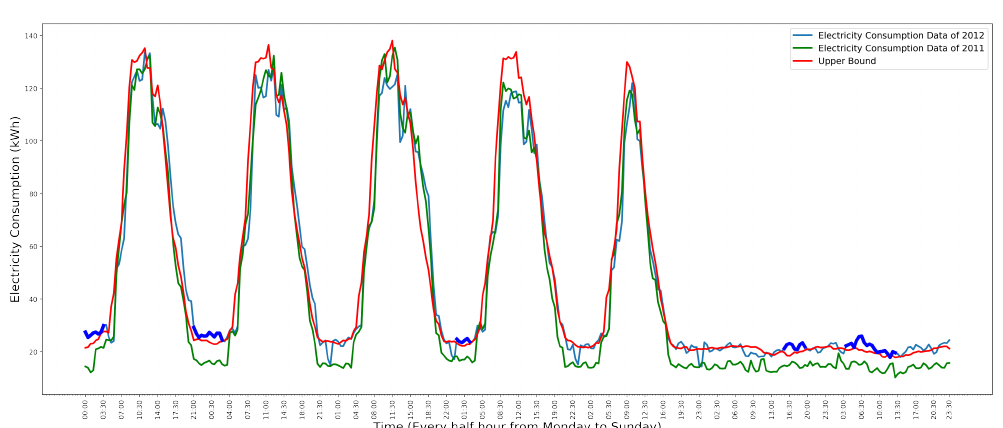
Figure 11. Anomaly detection based on the Gaussian distribution model. The x -axis is the time. The y -axis is the electricity consumption data. Adapted from [8].